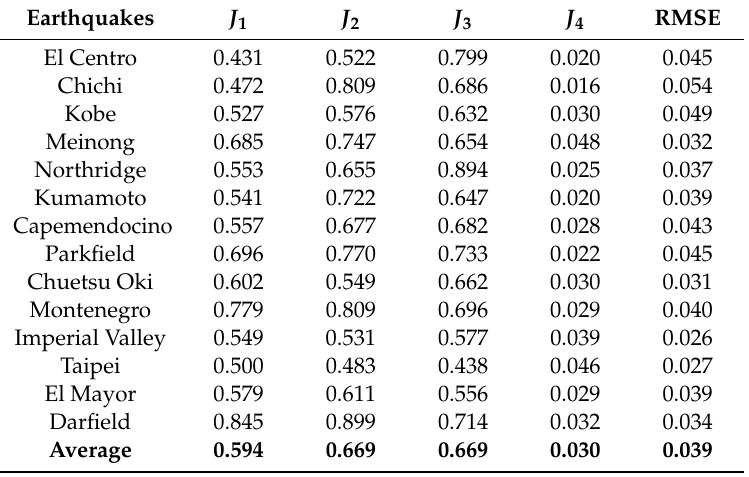
Table 7. Seismic control performance of the ARX (autoregressive with exogenous